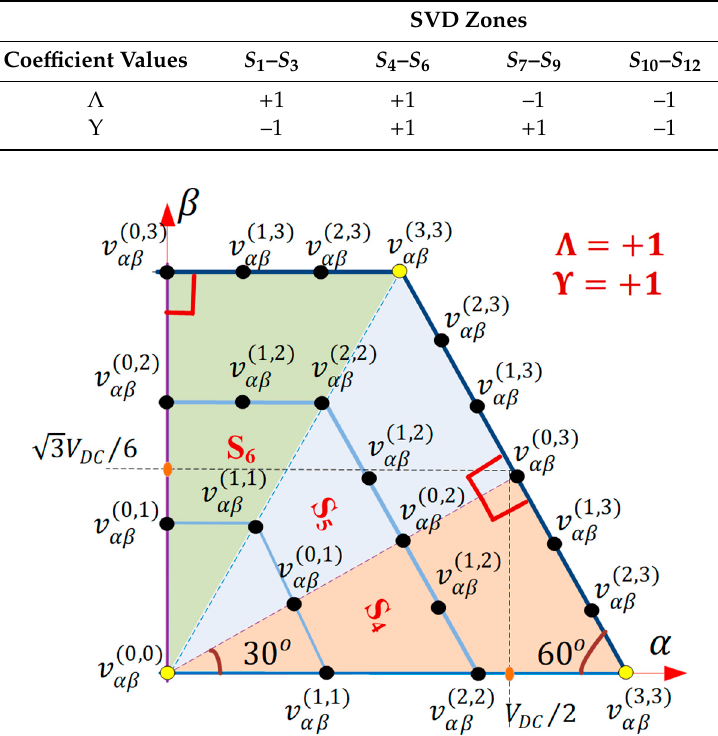
Table 1. Coe ffi cient values depending on SVD zones.